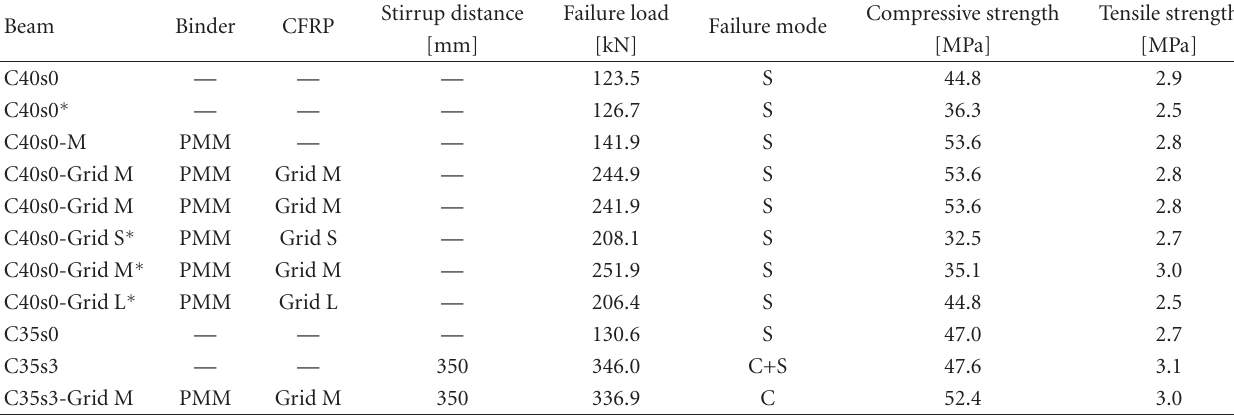
Table 3: Ultimate shear loads and failure modes, along with description of tested shear beams.